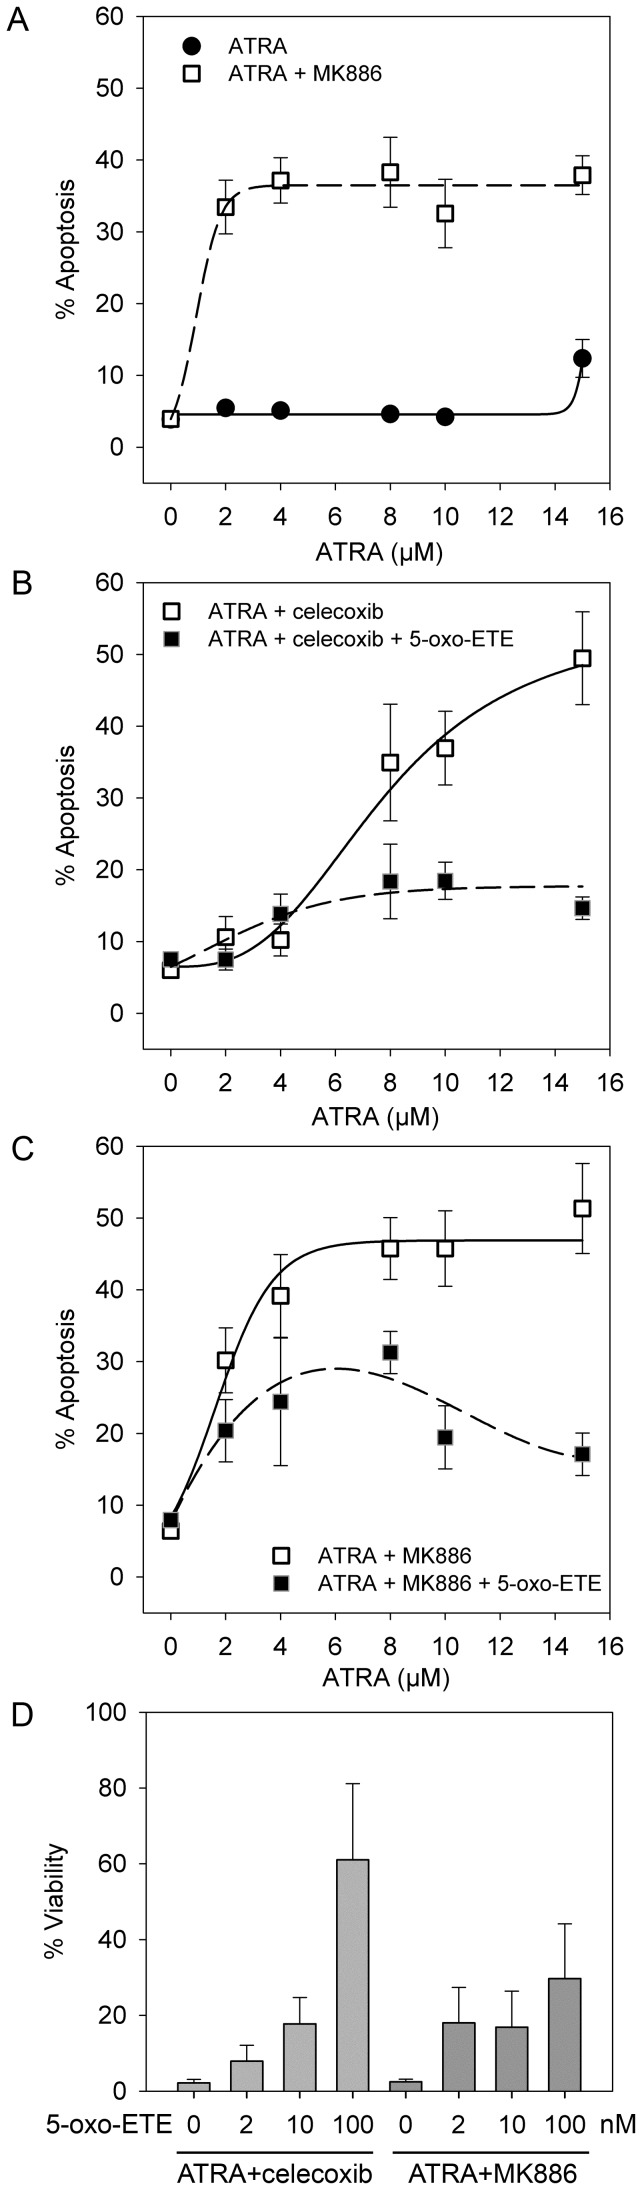
A 5-LO metabolite promotes cell survival after RA treatment.All graphs show data for SH-SY5Y cells. Apoptosis was measured by flow cytometry as the size of the sub-G1 peak. (A) Apoptosis of cells treated with increasing doses of ATRA alone (•, solid line) or with 1 µM MK886 (□, dashed line). The interaction P-value for MK886 and ATRA was<0.001 (ANOVA). Data for MK886 alone are in Table 1. (B) Apoptosis of cells treated with increasing doses of ATRA in combination with 22 µM celecoxib (□, solid line) or after pre-treatment with 0.1 µM 5-oxo-ETE prior to increasing doses of ATRA in combination with 22 µM celecoxib (▪, dashed line). The interaction between 5-oxo-ETE and celecoxib/ATRA was significant, P = 0.001 (ANOVA). (C) Apoptosis of cells treated with increasing doses of ATRA in combination with 1 µM MK886 (□, solid line) or after pre-treatment with 0.1 µM 5-oxo-ETE prior to increasing doses of ATRA in combination with 1 µM MK886 (▪, dashed line). The interaction between 5-oxo-ETE and MK886/ATRA was significant, P = 0.005 (ANOVA). (D) Rescue, expressed as % viability, of cells treated with 15 µM ATRA with 22 µM celecoxib (light grey bars) or ATRA with 1 µM MK886 (dark grey bars) by pre-treatment with increasing doses (0, 2 nM, 10 nM or 0.1 µM) 5-oxo-ETE. All error bars are±SEM.